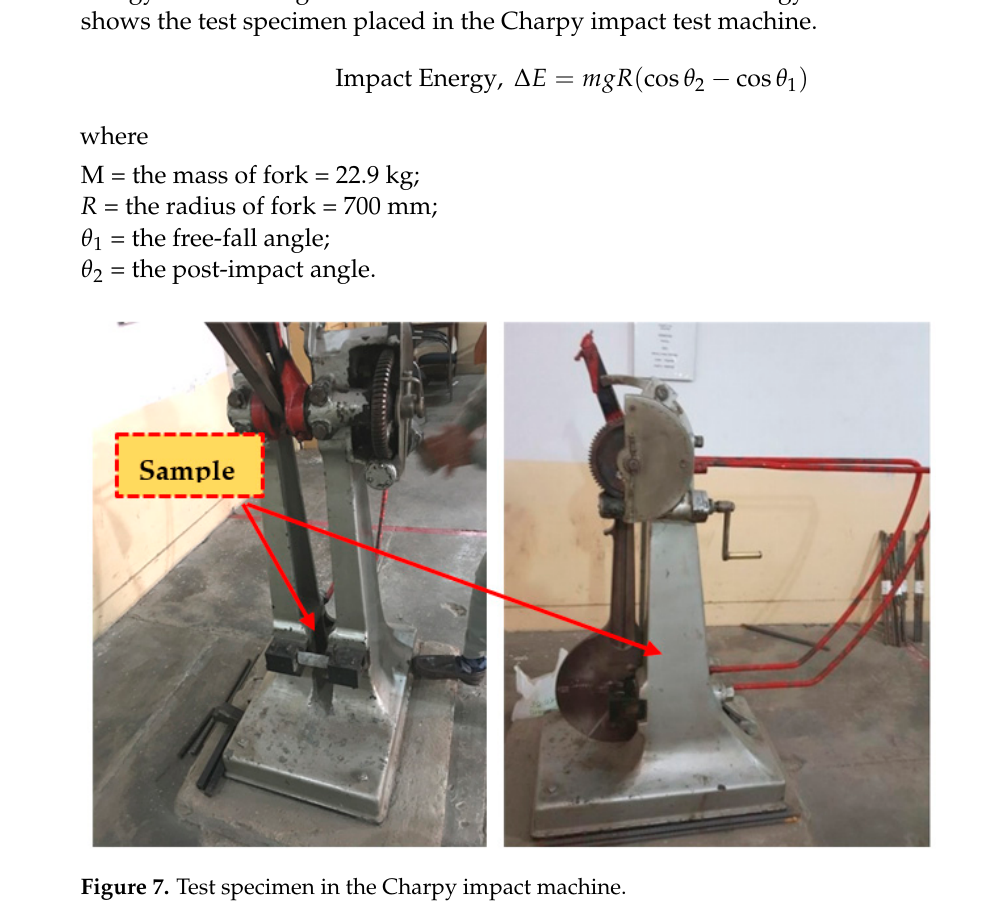
Figure 7. Test specimen in the Charpy impact